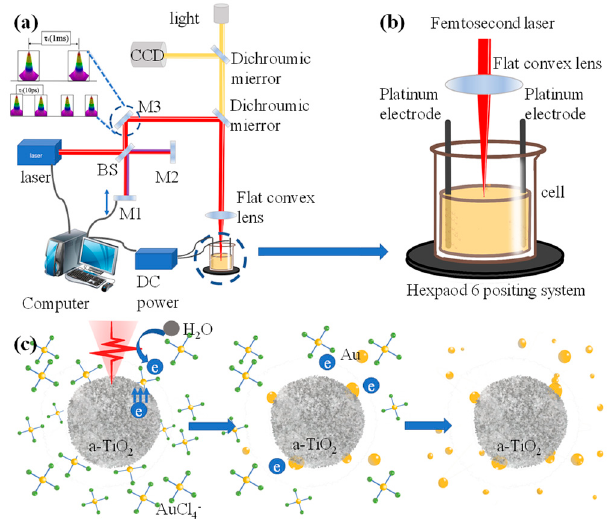
Figure 1. ( a ) Schematic of the optical path of the electric-field-assisted femtosecond laser liquid phase ablation; ( b ) schematic of the loading electric field; ( c ) a schematic diagram of the growth mechanism of AuNPs attached to a-TiO 2 under the Au 3+ and TiO 2 hydrate suspension under femtosecond laser irradiation.